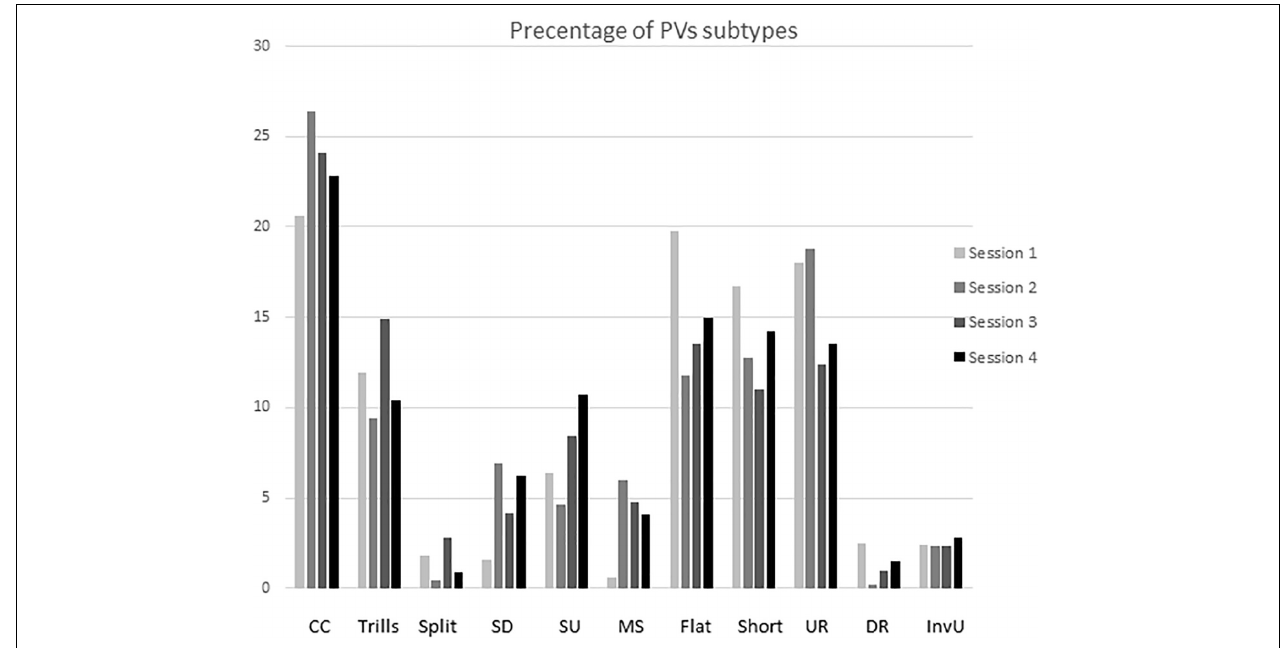
FIGURE 3 | Means percentage of different ultrasonic subtypes during the acquisition of sexual experience. Subtypes are represent as: complex and composite (CC), trill, flat-trill and trill with jumps (Trills), split, step up (SU), step down (SD), multi-step (MS), flat, short, upward ramp (UR), downward ramp (DR), and inverted U (IU). Subtypes on the X-axis are shown from left to right of each column as sessions 1, 2, 3, and 4.